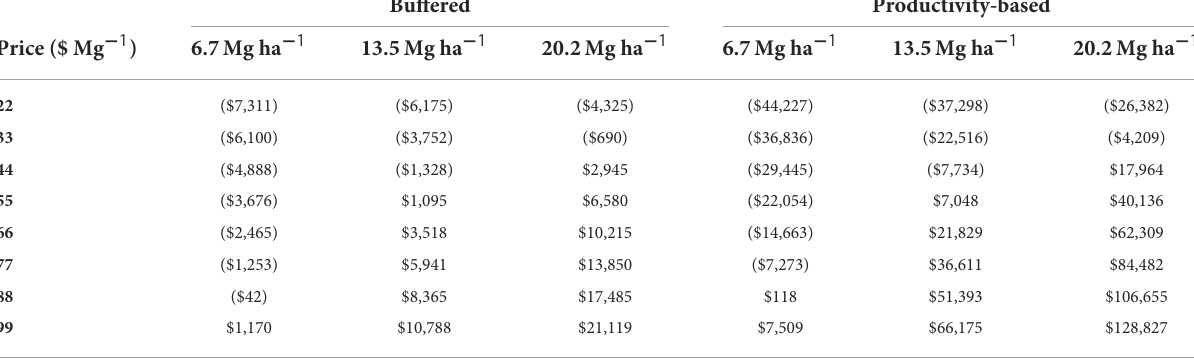
TABLE 3 Total annual net revenue generated from each modeled scenario in the Grand River Basin assuming yields of 6.7, 13.5, and 20.2Mg ha − 1 , farmgate selling prices between $22 and $99 Mg − 1 , and yield and scenario dependent annualized production costs. Buffered